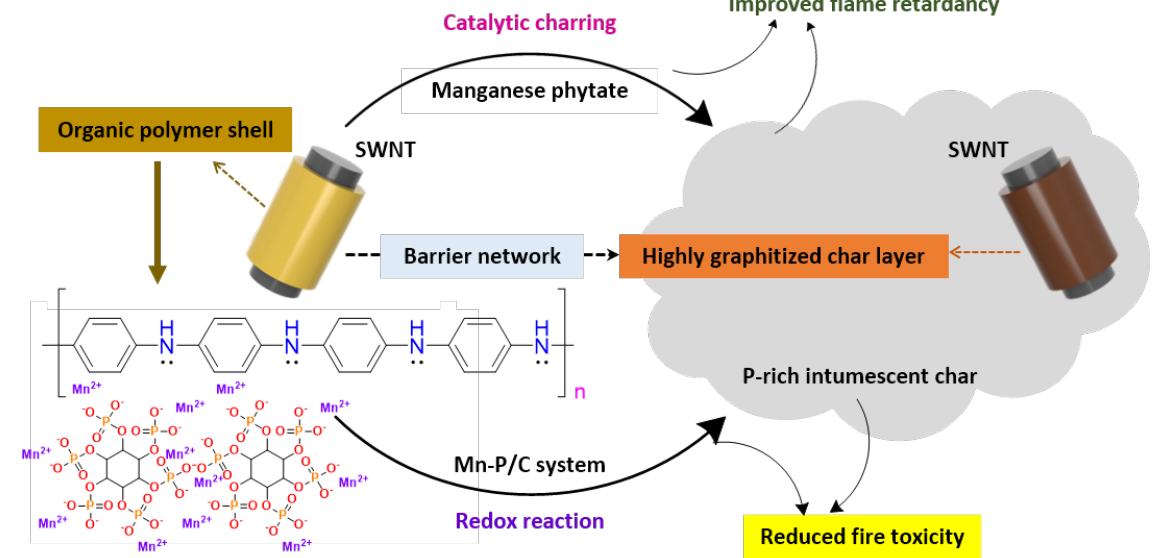
Figure 19. Schematic of proposed flame-retardant process for manganese pentacarbonate-dotted polyaniline-enwrapped carbon nanotubes (MPCNTs) in an epoxy composite. The dispersed state of the MPCNT particles contributes to the catalytic charring performance of the phytate structure generating a phosphorus-rich intumescent char residue and acts as a barrier network in the matrix and an efficient catalyst toward the redox reaction of the Mn-P/C system. Meanwhile, the highly graphitized char layer acts as an adhesive, making the SWNT network more close-grained. Reproduced with permission from Ref. [167]. Copyright 2018, Elsevier.